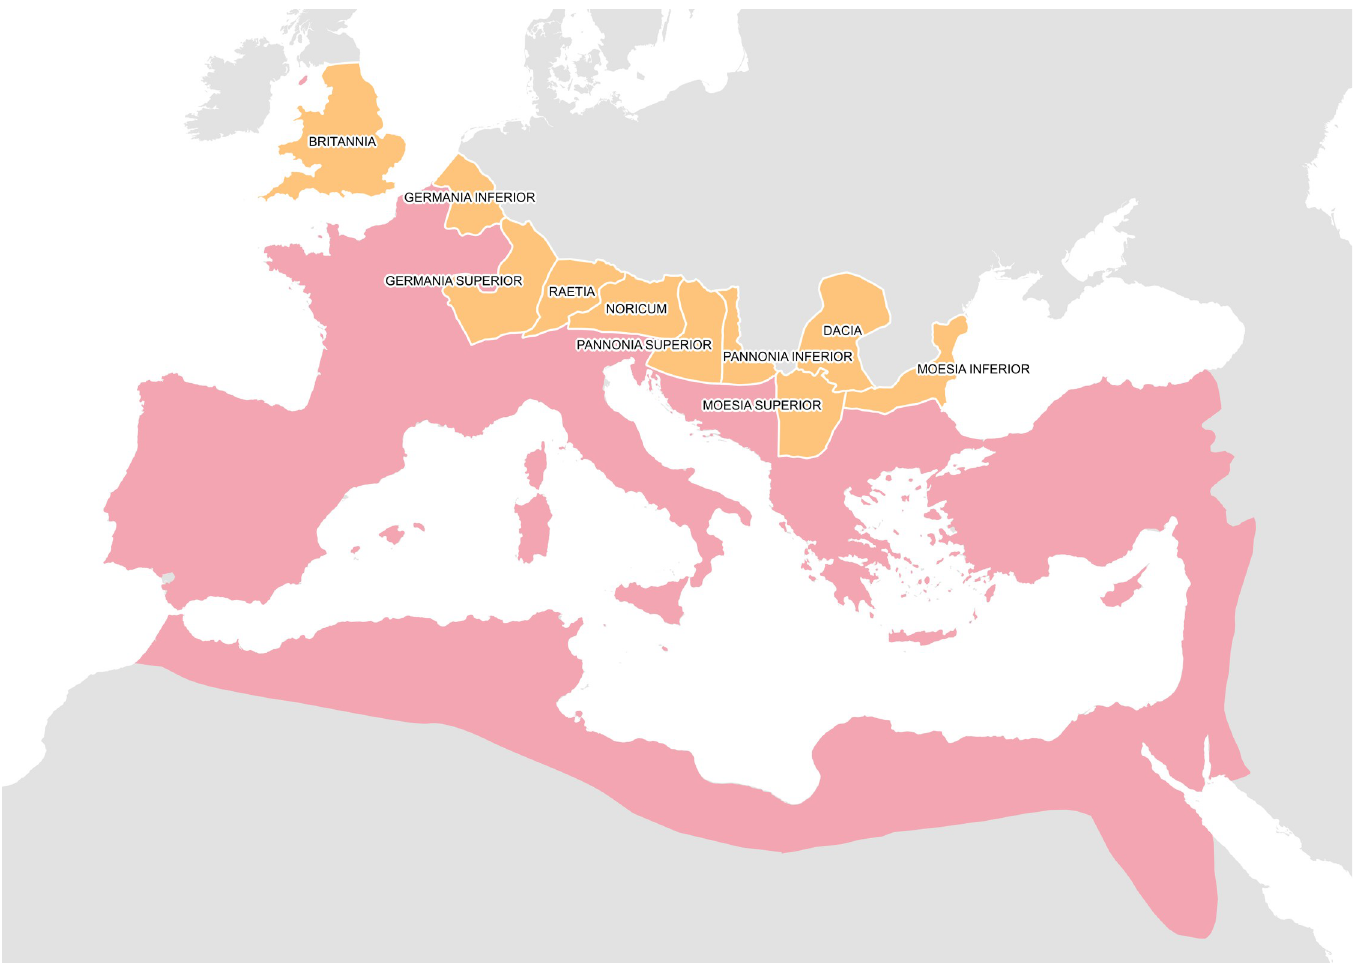
Fig 1. The area of interest. The provinces of interest are in orange, the Roman Empire in red. Sources: Natural Earth [31]; Ancient World Mapping Center (AWMC) [32] —Reprinted from AWMC database of shapefiles [32] under a CC BY license, with permission from AWMC, original copyright 2012.